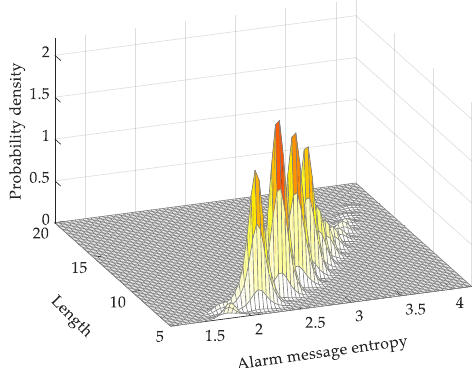
Figure 6. Probability density map of Term Frequency-Inverse Document Frequency (TF-IDF) alarm-message entropy.